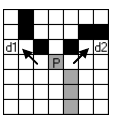
Figure 8. Determination of the forward direction at a pseudo crossing point